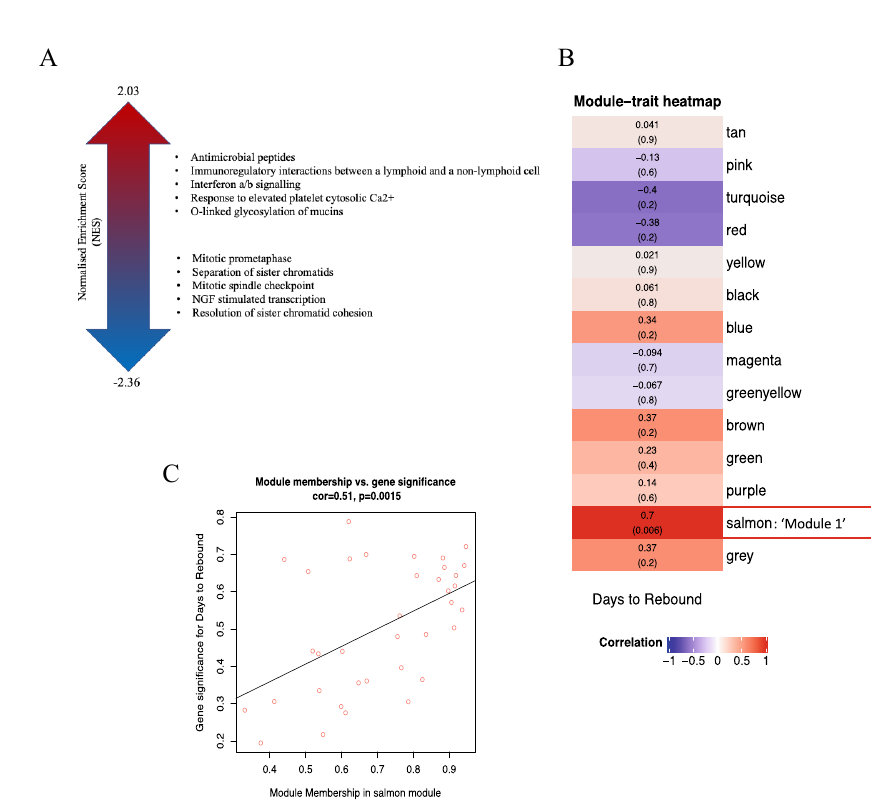
Figure 1. GSEA and WGCNA module identification and enrichment. ( A ) The top ten enriched pathways (FDR < 0.25) for Week 48 PTC vs ER by GSEA. Ranking is by Normalised Enrichment Score (NES). ( B ) Heatmap plot of WGCNA gene modules on TI associated with ‘days to rebound’. Trait correlations and statistical significance (in parenthesis) are shown for each module. Modules are colour-coded based on direction and intensity of correlation. The ‘salmon’ module which was identified for further analysis is marked with a box and labelled as ‘Module 1’. The heatmap was made with WGCNA (package version 1.70.3). ( C ) Scatterplot of gene significance (GS) for trait of interest versus module membership (MM) for Module